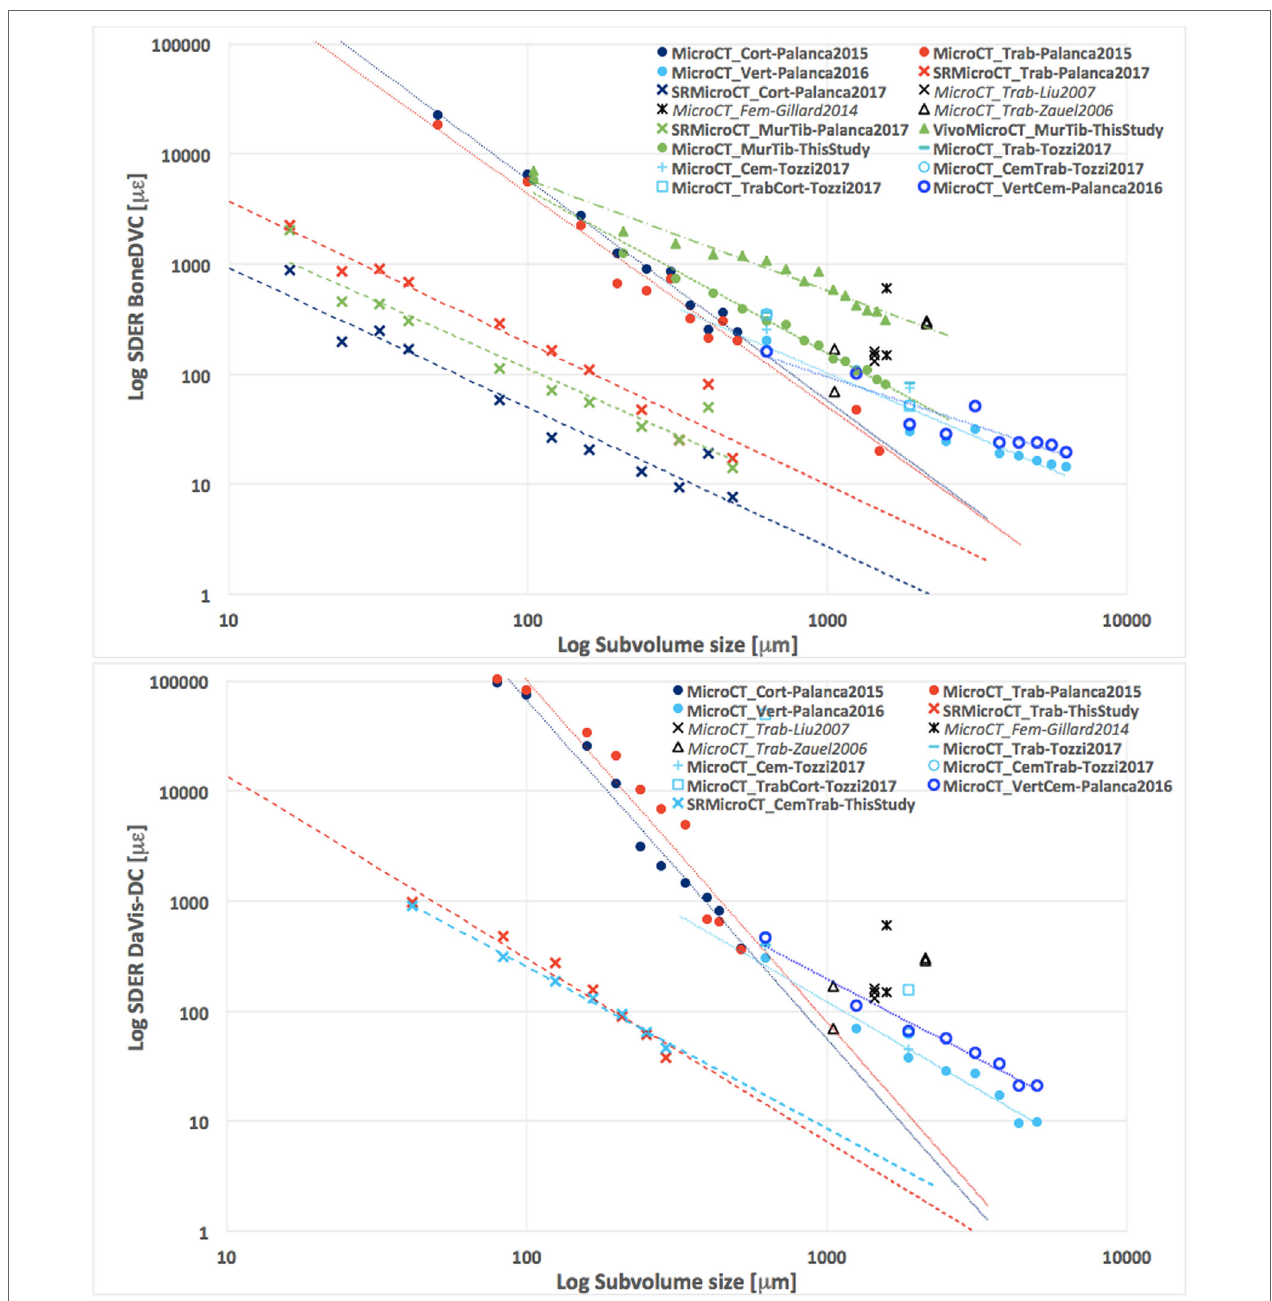
FigUre 2 | Relationship in logarithmic scale between the standard deviation of the error (SDER; median values in case more specimens were analyzed per group) and the subvolume size for both global (BoneDVC, top) and local (DaVis-DC, bottom) DVC approaches. Dataset include cortical (MicroCT_Cort-Palanca2015) and trabecular (MicroCT_Trab-Palanca2015) bone scanned with laboratory micro-computed tomography ( μ CT) at 10 µm voxel size; mouse tibiae scanned with in vivo (VivoMicroCT_MurTib-ThisStudy) and ex vivo (MicroCT_MurTib-ThisStudy) settings with a μ CT at 10.4 µm voxel size; porcine vertebrae with (MicroCT_VertCem- Palanca2016) or without (MicroCT_Vert-Palanca2016) biomaterial scanned with μ CT at 39 µm voxel size; portions of trabecular (MicroCT_Trab-Tozzi2017), cement (MicroCT_Cem-Tozzi2017), trabecular and cement (MicroCT_CemTrab-Tozzi2017), and trabecular and cortical bone (MicroCT_TrabCort-Tozzi2017) extracted from augmented porcine vertebrae scanned with μ CT at 39 µm voxel size; cortical (SRmicroCT_Cort-Palanca2017), trabecular (SRmicroCT_Trab-Palanca2017) and mouse tibia (SRmicroCT_MurTib-Palanca2017) scanned with synchrotron light μ CT (SR μ CT) at 1.6 µm voxel size; ovine trabecular bone with (SRmicroCT_CemTrab- ThisStudy) and without (SRmicroCT_Trab-ThisStudy) scanned with SR μ CT at 2.6 µm voxel size. In order to do not overcomplicate the figure, the error bars were not reported and the interested reader should refer to the specific publications for this information. Data extracted form the literature have been also added for both graphs (MicroCT_Trab-Liu2007 for data obtained from bovine distal femur, bovine proximal tibia, rabbit distal femur, rabbit proximal tibia, rabbit vertebral body, and human vertebral body, all acquired with μ CT at 36 µm voxel size, MicroCT_Trab-Zauel2006 for data obtained from human femoral and vertebral trabecular bone acquired with μ CT at 35 µm voxel size; MicroCT_Fem-Gillard2014 for data obtained from porcine femoral trabecular bone acquired with μ CT at 24.6